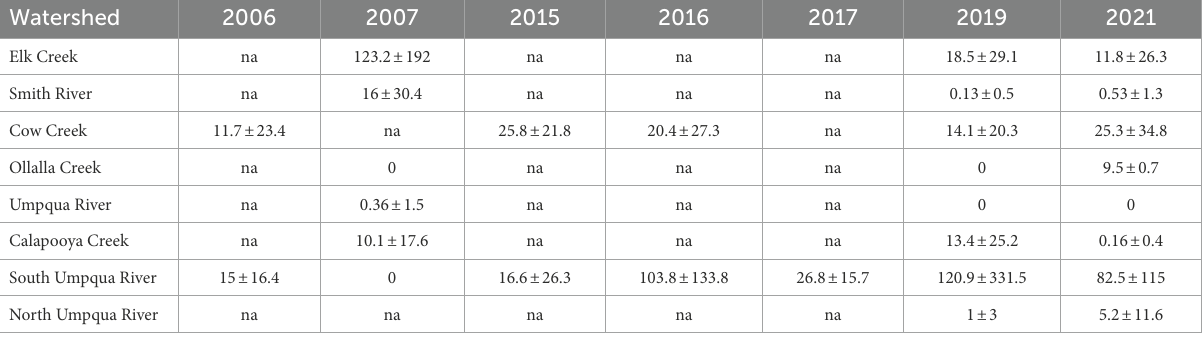
na indicates watershed was not surveyed in that year. TABLE 3C The mean ± standard deviation of the maximum number (between repeated surveys) of smallmouth bass in two-species multi-state models, by watershed and year (2006–2021) counted within the Umpqua basin, Oregon, United States (2006–2007 surveys only surveyed once).